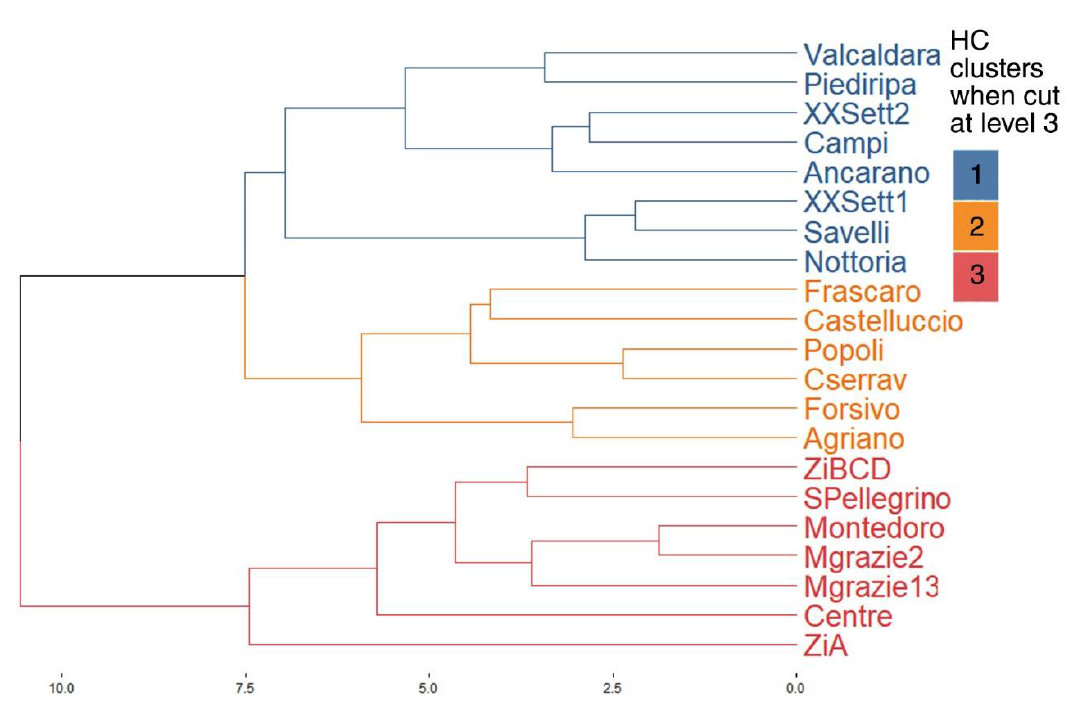
Figure 15 HC-derived VGA dendrogram with the tree is cut at